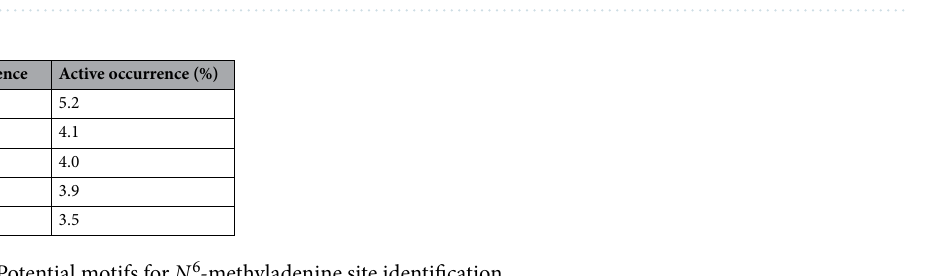
Table 8. Potential motifs for N